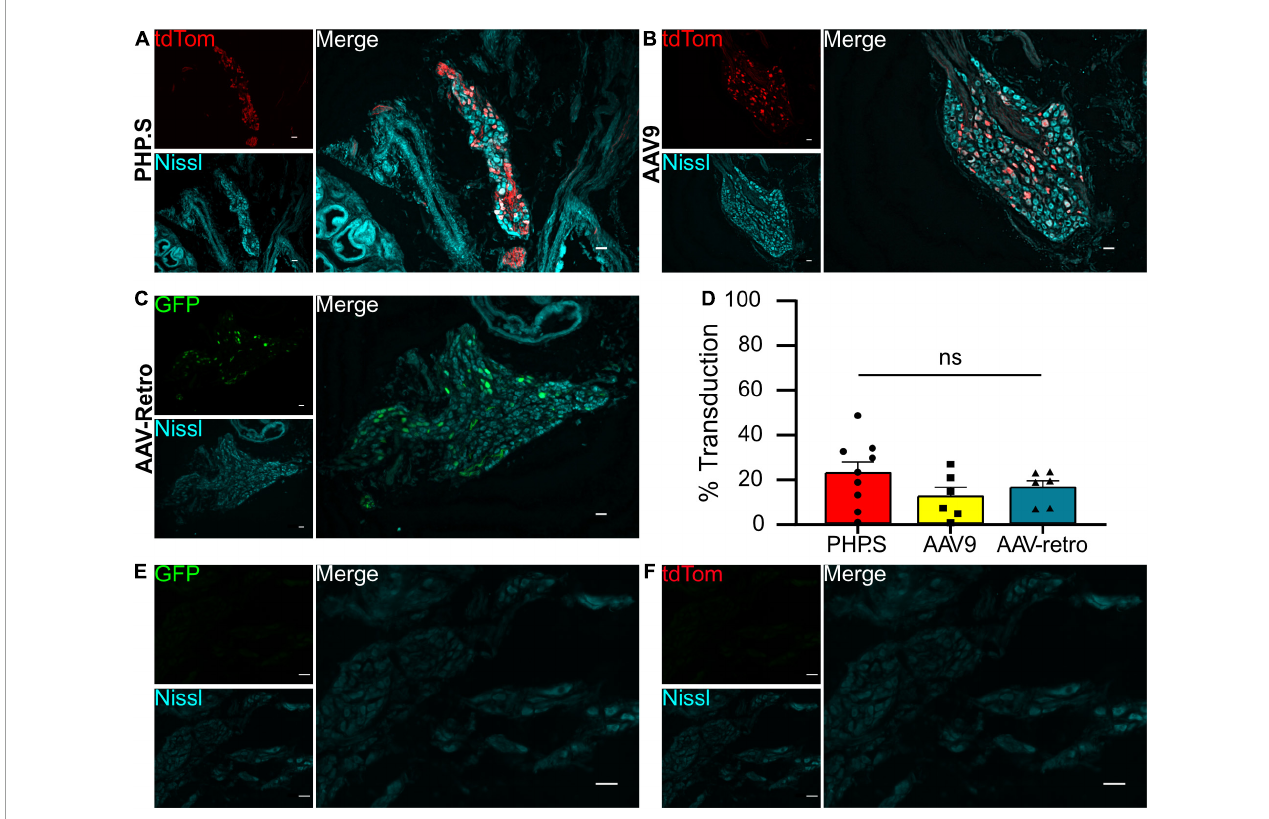
FIGURE2 Systemic PHP.S, AAV9, and adeno-associated viruses (AAV)-retro transduce pelvic ganglion neurons at similar rates. (A) Representative image of tdTomato expression in the pelvic ganglion of PHP.S-injected rats. Neurons marked with Nissl (scale bar, 50 µ m). (B) Representative image of tdTomato expression in the pelvic ganglion of AAV9-injected rats. Neurons were marked with Nissl (scale bar, 50 µ m). (C) Representative image of GFP expression in the pelvic ganglion of AAV-retro-injected rats. Neurons marked with Nissl (scale bar, 50 µ m). (D) Quantification of transduced neurons in pelvic ganglia using one-way ANOVA indicated no significant difference between PHP.S ( n = 9 animals), AAV9 ( n = 6), and AAV-retro ( n = 6) ( p = 0.3176). (E,F) Images of pelvic ganglia from vehicle-injected rats with the corresponding fluorescent channels for GFP (E) and tdTomato (F) (scale bar, 50 µ m).